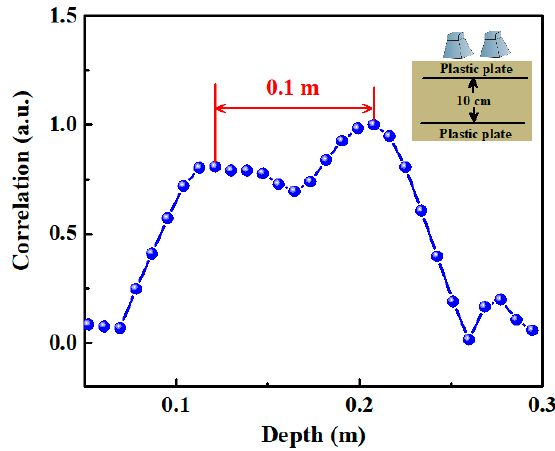
Figure 8. Identification of two reflection targets with 10 cm spacing.